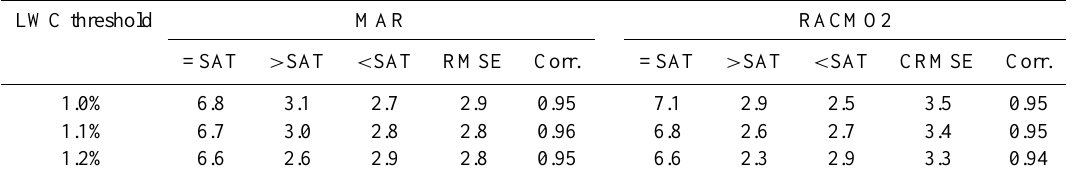
Table 5. The same as Table 4 but for ExtXPGR with T19H thsd =227.5K. LWC threshold MAR RACMO2 =SAT > SAT < SAT RMSE Corr. =SAT > SAT < SAT CRMSE Corr. 1.0% 6.8 3.1 2.7 2.9 0.95 7.1 2.5 0.95 1.1%